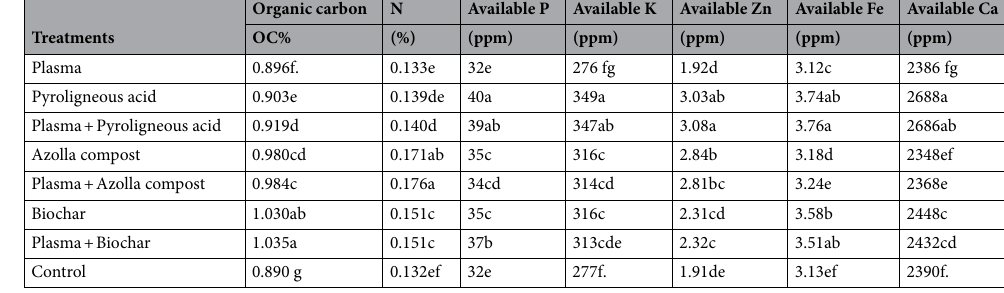
Table 6. Mean comparison of effect of application of plasma, pyroligneous acid, azolla compost and biochar on chemical changes of soil in the field average 2016–17. Means in each column followed by similar letter(s) are not significantly different at 5% probability level using LSD Range Test.